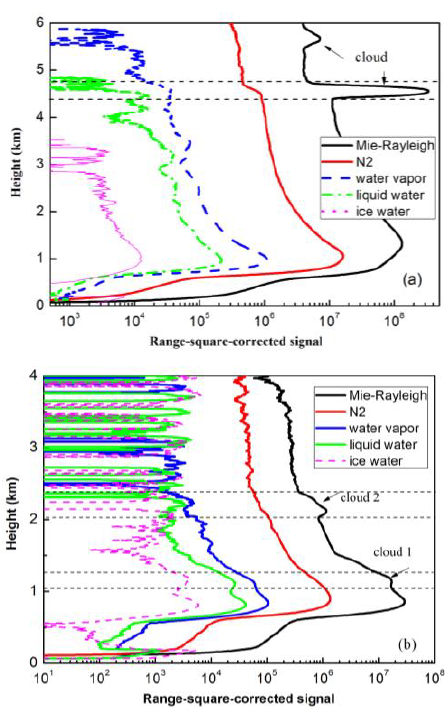
Fig.2 Representative measurement examples under cloudy weather condition. (a) Range-square-corrected signal taken at 21:39 CST on 29 Sep, 2018. (b) Range- square-corrected signal taken at 22:35 CST on March 4, 2019.